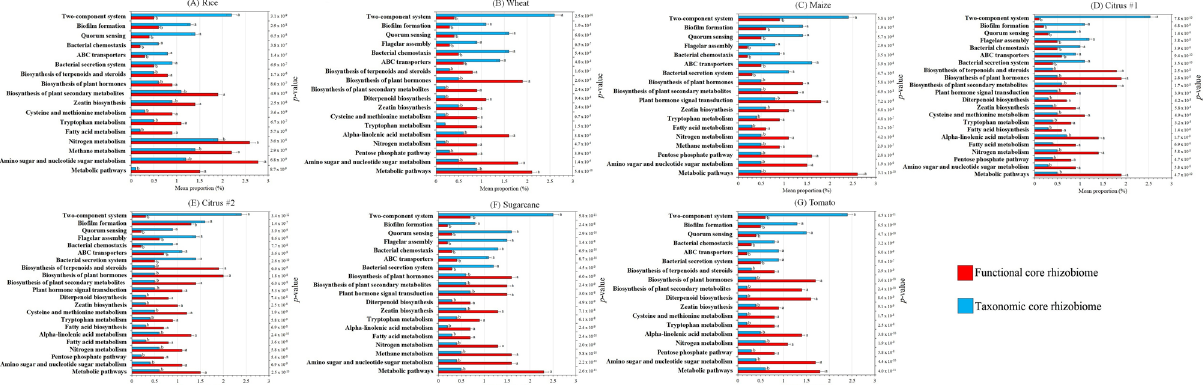
Figure 3. Histograms of predicted pathways significantly different between taxonomic and functional core rhizobiome samples according to the Welch’s t-test and Benjamini–Hochberg FDR multiple test correction for rice ( A ), wheat ( B ), maize ( C ), citrus #1 ( D ), citrus #2 ( E ), sugarcane ( F ), and tomato ( G ). The mean proportion (%) of the predicted pathways in each taxonomic or functional core rhizobiome is shown. Letters above the bars indicate significant differences in the relative abundance of each pathway between taxonomic and functional core rhizobiomes, and p -values < 0.05 were considered significant. Bars marked with the same letter are not significantly